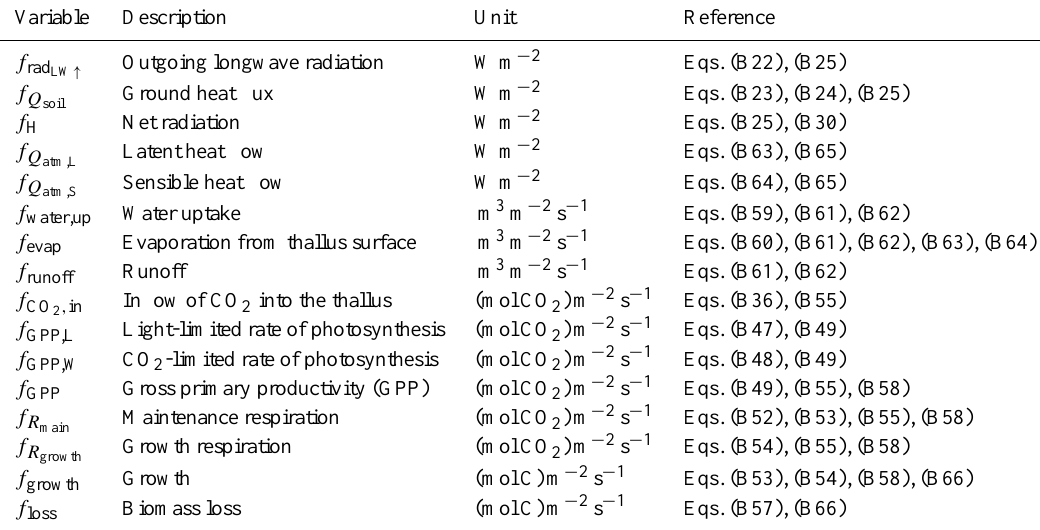
Table B15. Variables describing flows between lichens or bryophytes and their environment.